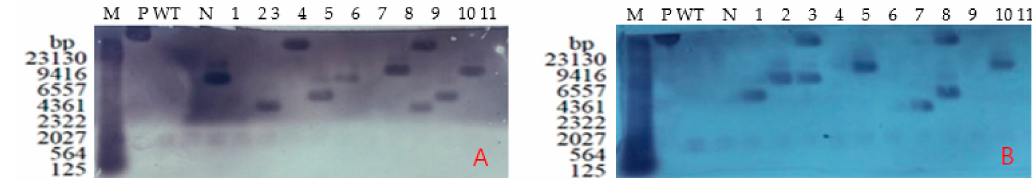
Figure 4. Detection of T 3 generation positive plants by Southern blotting. ( A ) Target g3 progeny detection; ( B ) Target g6 progeny detection. M: Marker; P: Plasmid; WT: Wild Type; N: Negative signal (trans clean mutant